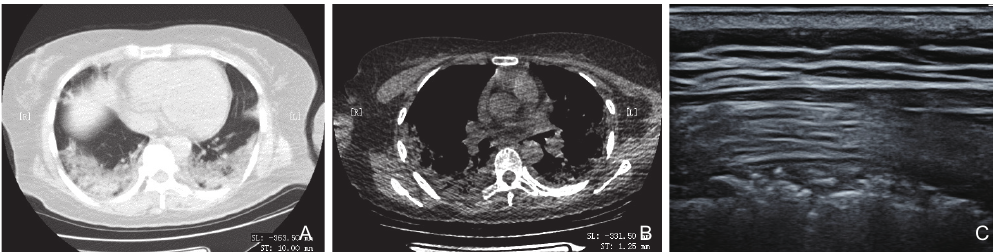
Figure 11 Early advanced stage of COVID-19 ultrasound images. (A and B) CT images of lung window and mediastinal window. A 42-year-old female COVID-19 patient on the 7th days of fever with body temperature up to 38.5°C. High-resolution CT (HRCT) showed right upper lobe subpleural heterogenous band-like shadows; (C) Ultrasound using a linear array probe showed interrupted and disappeared pleural line in the upper right lung field and a subpleural strip-like faint solid lung tissue. Air bronchogram sign and B-lines were also seen.